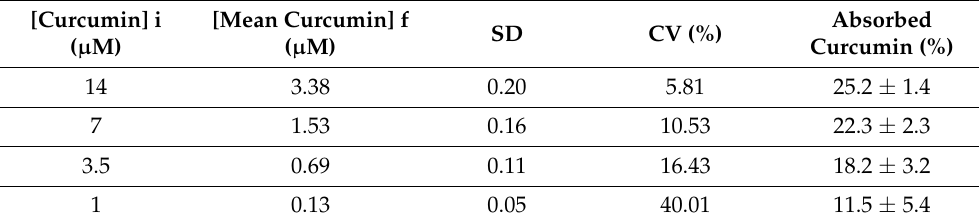
Table 2. Concentration of curcumin absorbed by one million mdMSCs after 10 min incubation at